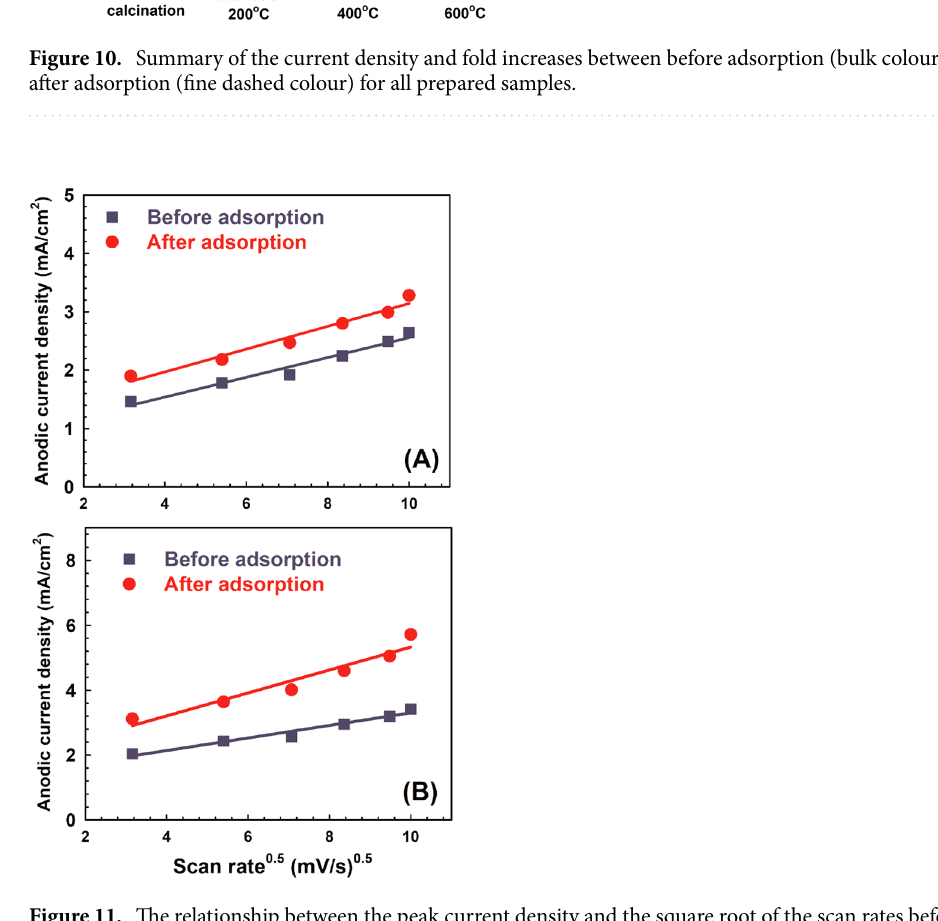
Figure 11. The relationship between the peak current density and the square root of the scan rates before and after adsorption for ( A ) LDH without calcination and ( B ) sample calcined at 200 °C under optimum